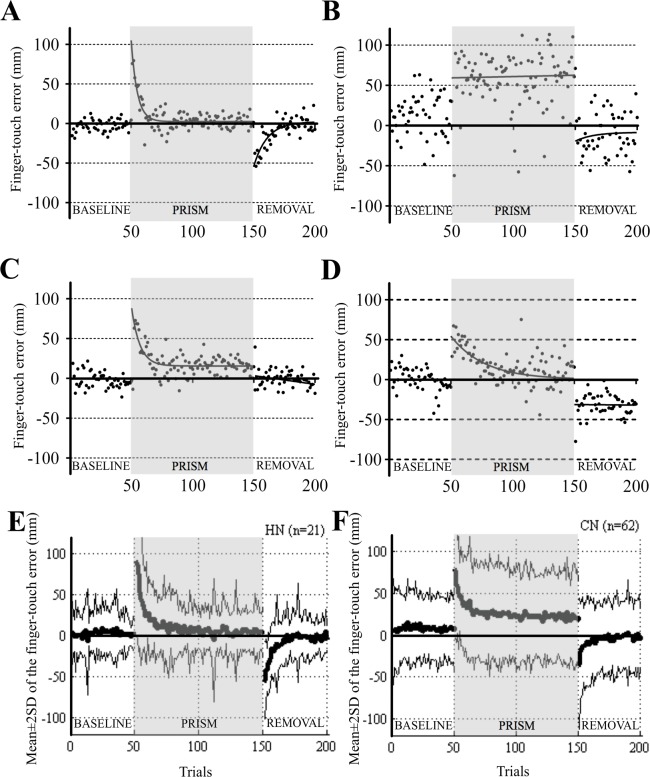
Adaptation curves in different subjects and in healthy and patient groups.(A)–(D) Adaptation curves in HN13 (A), CN4 (B), CN3 (C), and CN15 (D). The ordinate shows the finger-touch error represented by the distance (mm) from the target to the touch point. Positive values indicate rightward shifts and negative values indicate leftward shifts. The abscissa shows the trial numbers. Best-fitted exponential curves (for details, see Materials and Methods) are overlaid on the raw data. Whereas a normal subject (HN13) shows typical adaptation (A), patients with cerebellar diseases show three different patterns of impaired adaptation (B)–(D). (E) and (F) Average adaptation curves for 21 HN subjects (E) and 62 CN patients (F). Thick and thin curves show mean and mean ± 2SD, respectively.